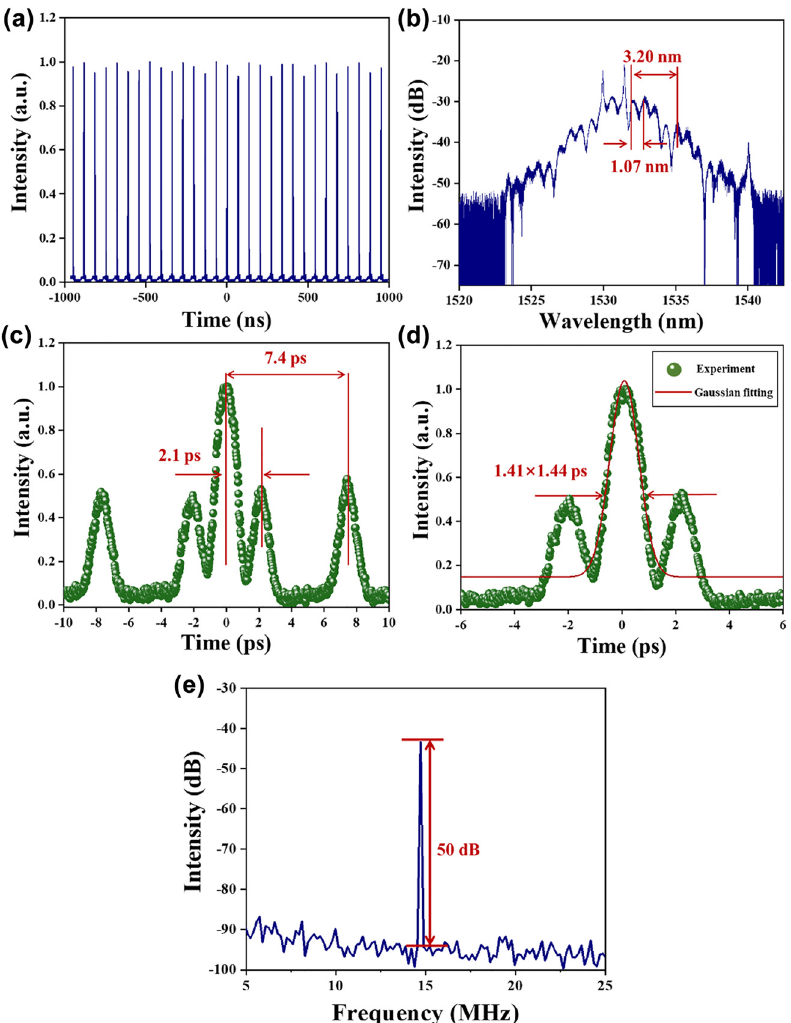
Figure 5: The output characteristics of Cr based SA bound-state soliton operation: (a) Pulse train. (b) Emission optical spectrum.